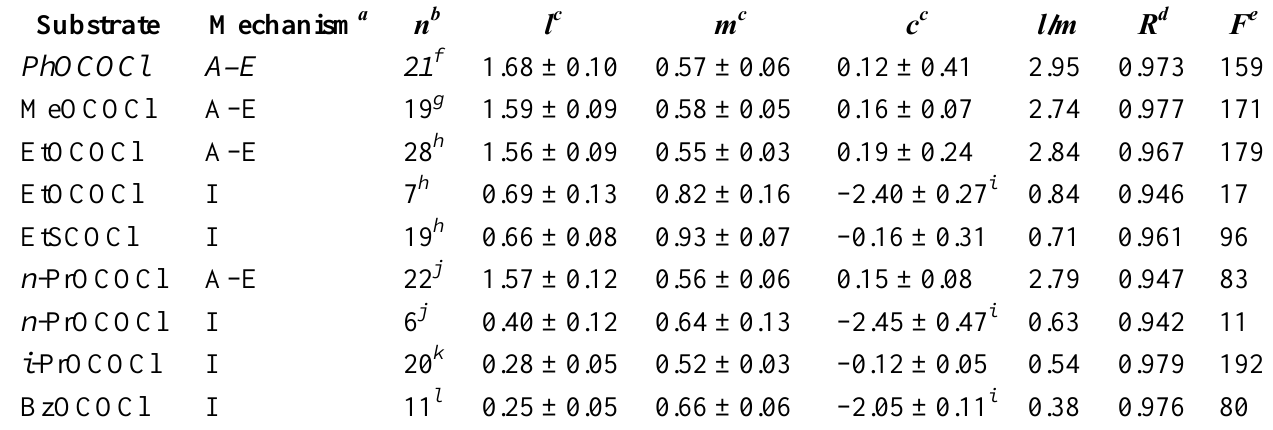
Table 4. Correlation of the specific rates of the solvolyses of methyl, ethyl, n